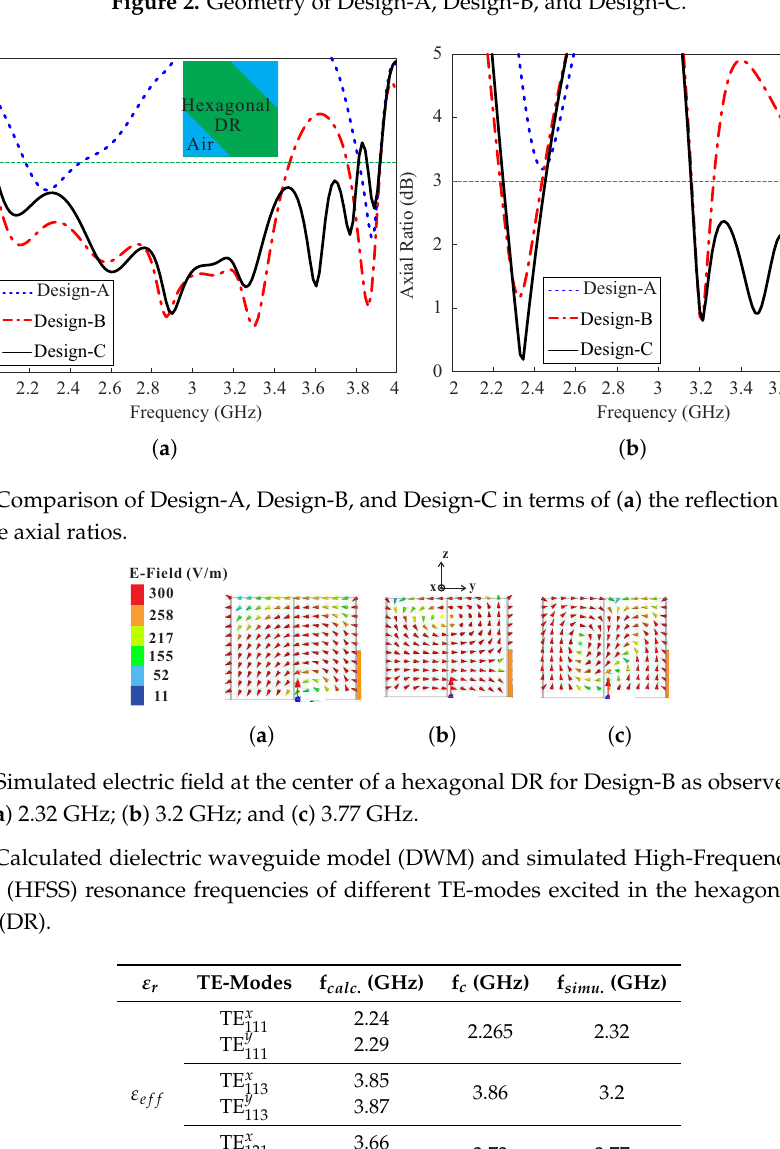
Figure 2. Geometry of Design-A, Design-B, and Design-C.